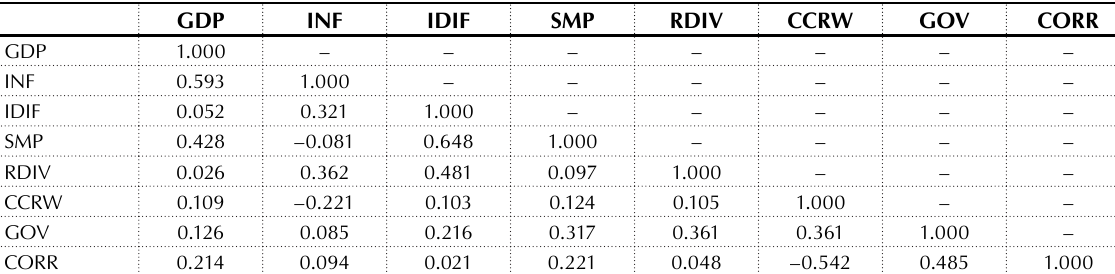
Table 3. Results of Augmented Dickey-Fuller